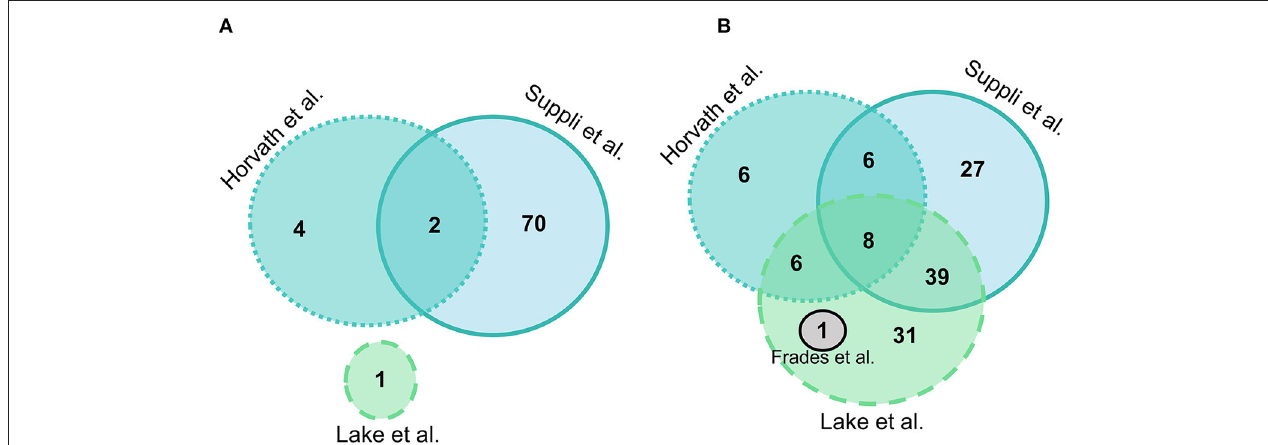
FIGURE 2 | Euler diagram of the number of significantly differentially expressed genes (adjusted P -value < 0.05) in liver samples: (A) Normal-weight controls vs. steatosis; (B) Normal-weight controls vs. NASH. Grey indicates Frades et al. (25), light blue indicates Suppli et al. (29), green indicates Lake et al. (30), aqua indicates Horvath et al. ( 31).